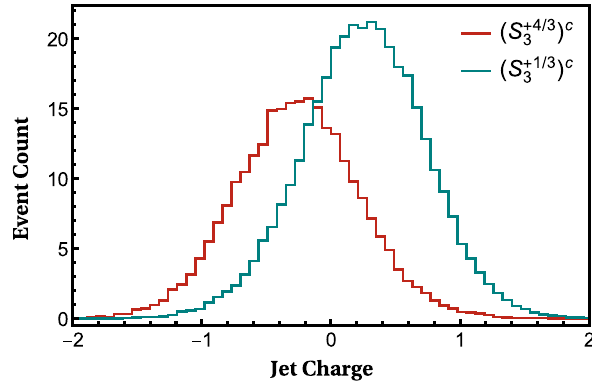
Fig. 8 Reconstructed charge (in the unit of e ) of c / s -jets coming from the scalar triplet leptoquark decay Table8